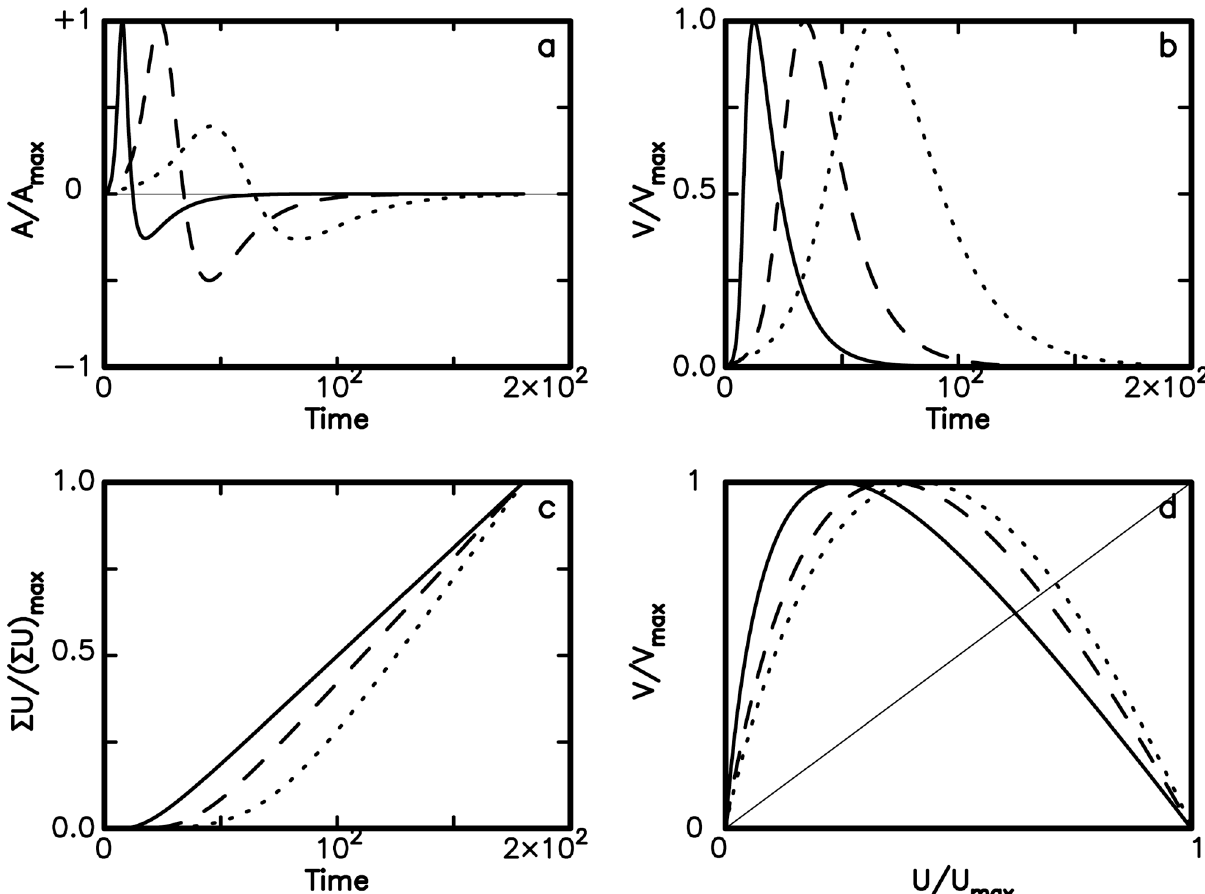
), normalized velocity ( V / V max versus U / U of the slider, acted by TP friction of F ( U )= exp(− U / U max max